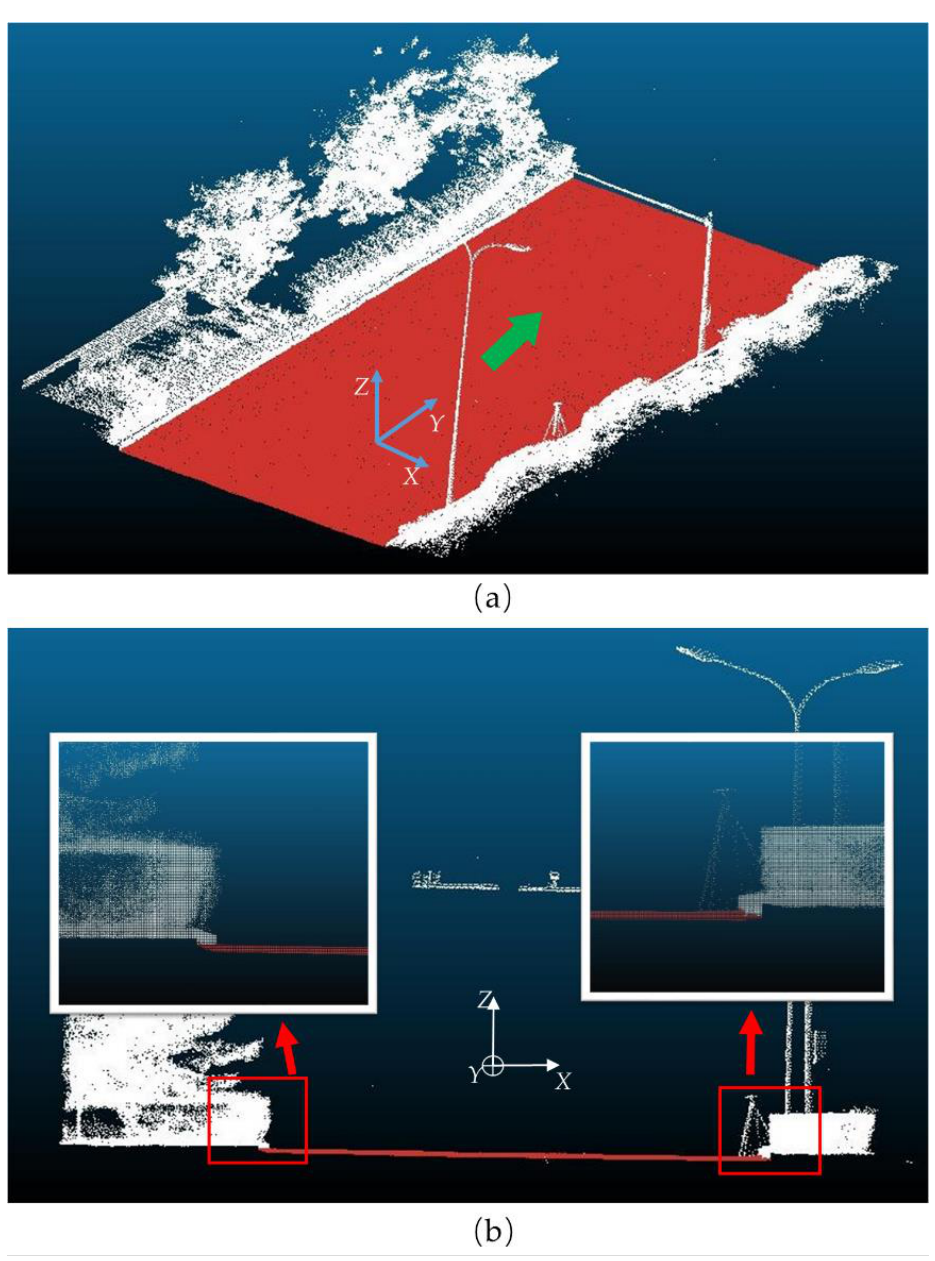
Figure 12. Results of road surface segmentation: ( a ) 3D view; ( b ) close-up views of road edges projected in the XOZ plane.